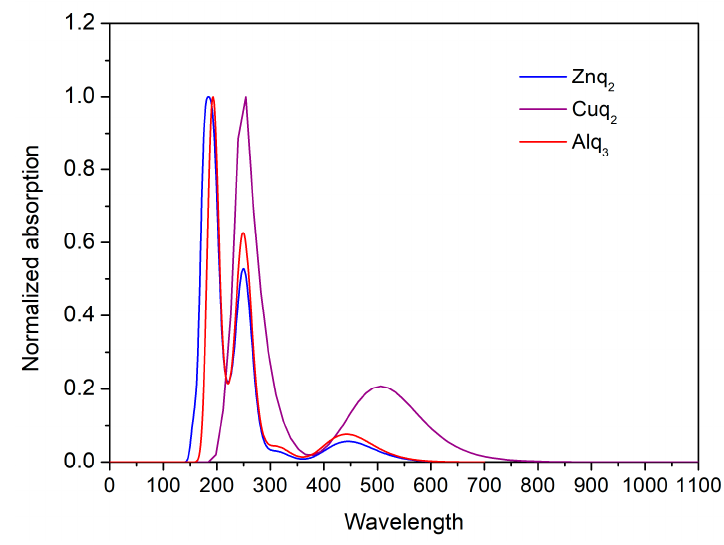
Figure 8. Optimized structures of investigated molecules: ( a ) Znq 2 , ( b ) Cuq 2 , ( c ) Alq 3 .